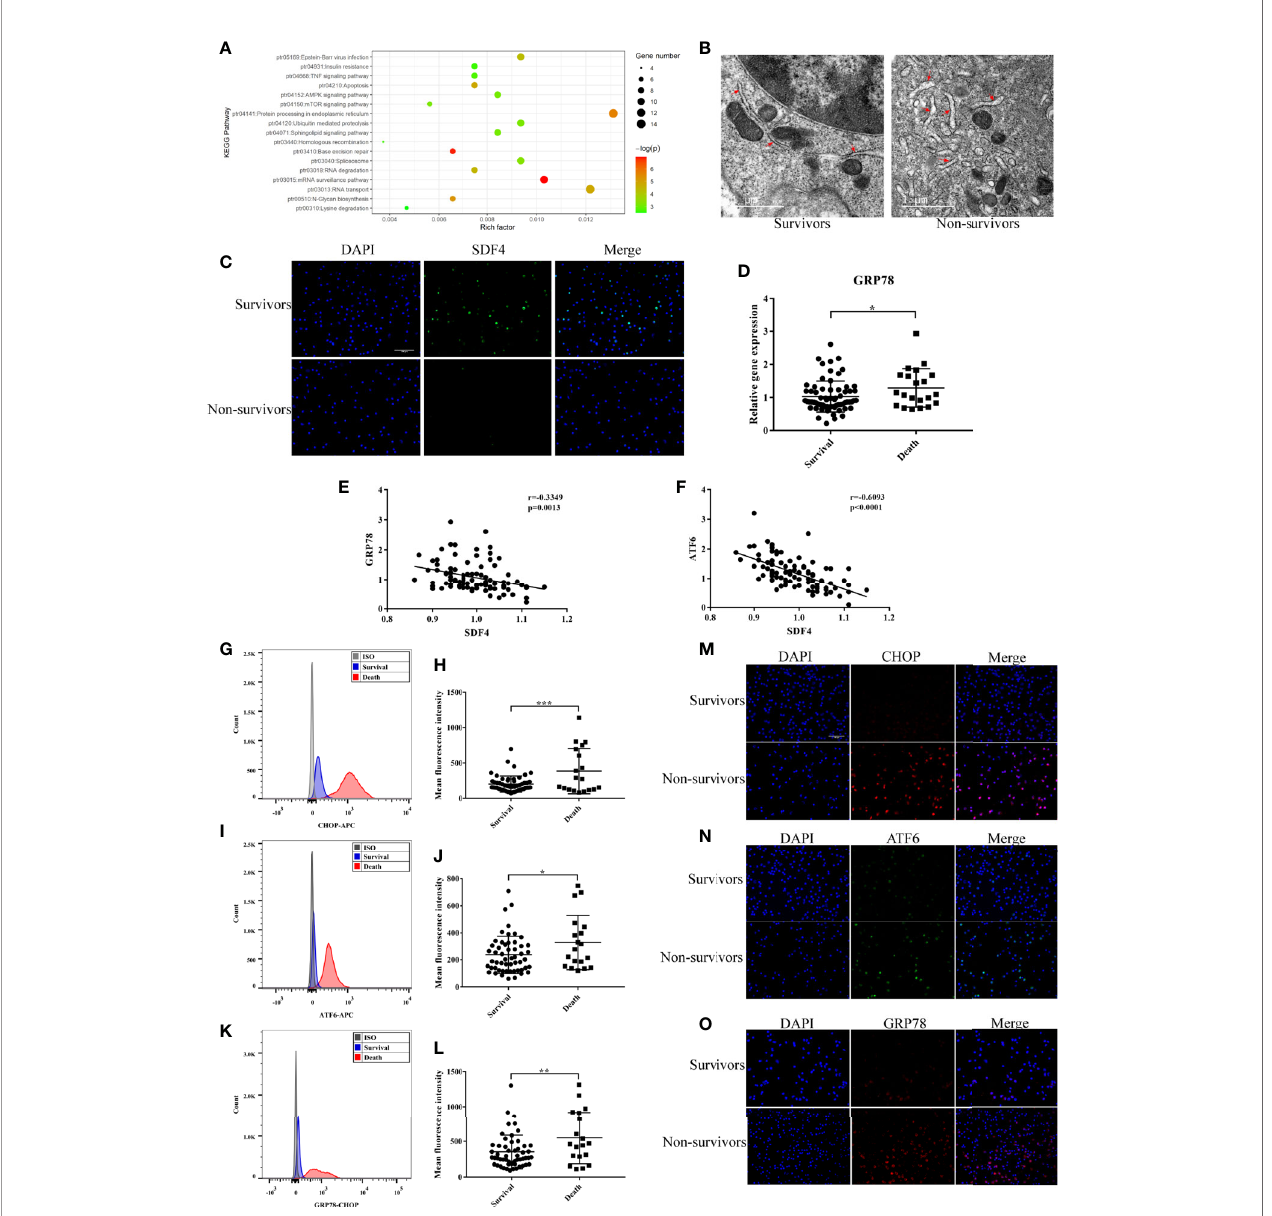
FIGURE 5 | (A) Kyoto Encyclopedia of Genes and Genomes (KEGG) enrichment analysis of DEGs (p < 0.05). (B) Representative TEM picture in survival and death. (C) Representative photomicrographs showing SDF4 (green), DAPI (blue) and their merged images (original magni fi cation ×400). Scale bar, 100um. (D) GRP78 expression in survival (n=68) compared with death (n=21) in cohort. (E) Pearson correlation analysis between the expression level of GRP78 and SDF4 in cohort. (F) Pearson correlation analysis between the expression level of ATF6 and SDF4 in cohort. (G) Representative histograms of CHOP expression among survival and death in fl ow cytometry. (H) Mean fl uorescence intensity of CHOP in survival (n=54) and death (n=19). (I) Representative histograms of ATF6 expression among survival and death in fl ow cytometry. (J) Mean fl uorescence intensity of ATF6 in survival and death. (K) Representative histograms of GRP78 expression among survival and death in fl ow cytometry. (L) Mean fl uorescence intensity of GRP78 in survival and death. (M) Representative photomicrographs showing CHOP (red), DAPI (blue) and their merged images (original magni fi cation ×400). Scale bar, 100um. (N) Representative photomicrographs showing ATF6 (green), DAPI (blue) and their merged images (original magni fi cation ×400). (O) Representative photomicrographs showing GRP78 (red), DAPI (blue) and their merged images (original magni fi cation ×400). ***p < 0.001, **p < 0.01, *p <